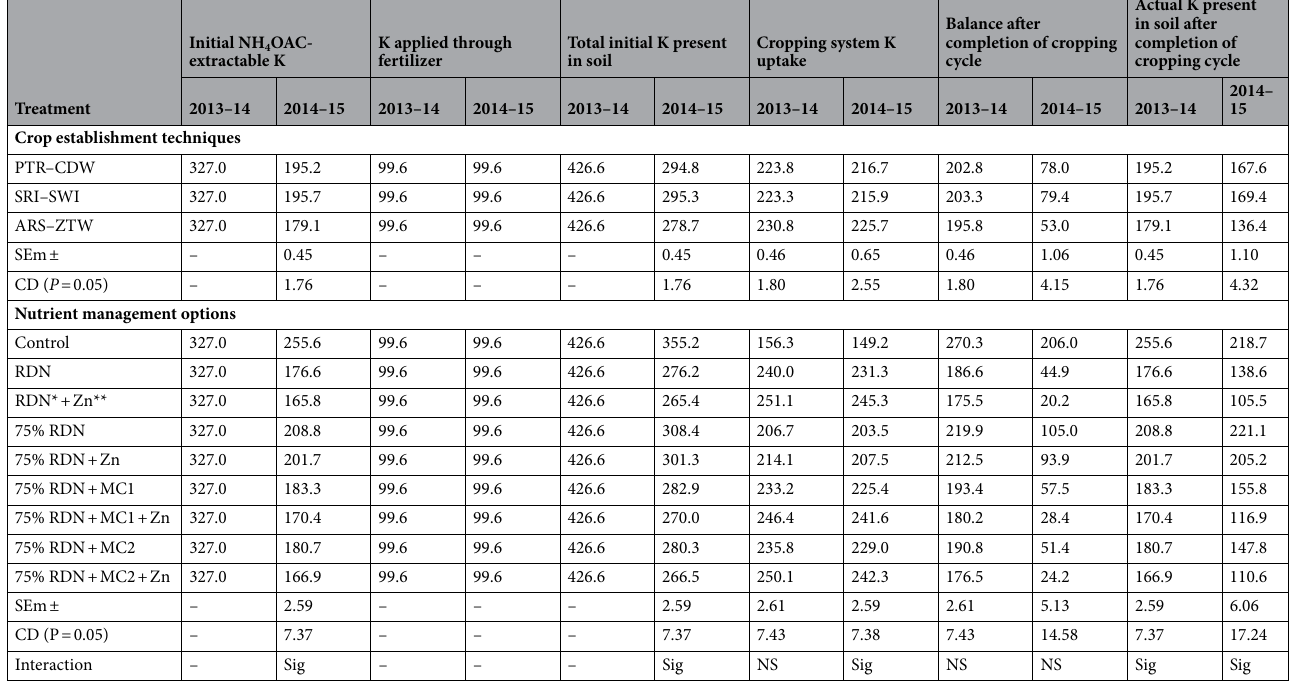
Table 12. Effect of crop establishment techniques and nutrient management options on potassium (K)